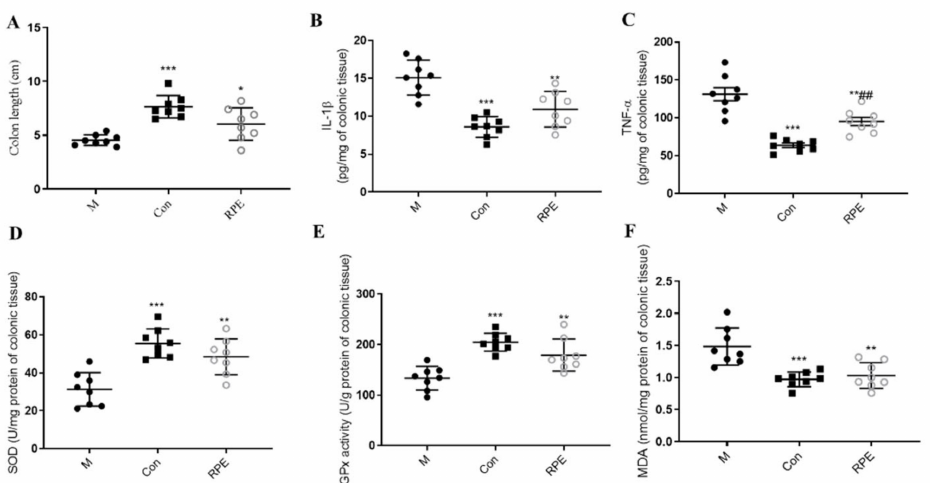
Figure 2. Effects of Rosa roxburghii fruit polyphenols extract on the colon length ( A ), colonic IL- β ( B ), colonic TNF- α ( C ), colonic superoxide dismutase (SOD) ( D ), colonic glutathione peroxidase (GPx) ( E ), and colonic malondialdehyde (MDA) ( F ) in STZ-induced diabetic mice. Note: * p < 0.05, ** p < 0.01, and *** p < 0.001 versus the M group; ## p < 0.01, versus the Con